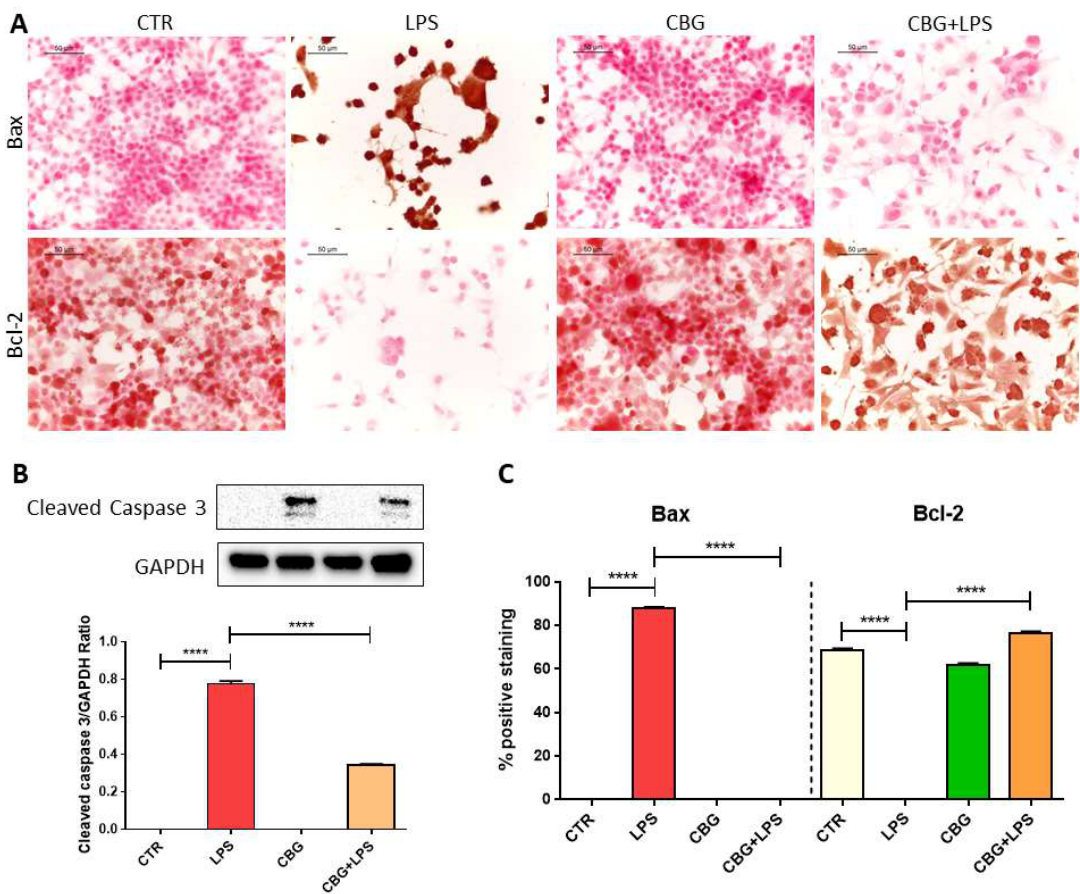
Figure 2. CBG pre-treatment was able to inhibit apoptosis induced by the medium of LPS-stimulated macrophages in NSC-34 motor neurons. ( A ) Immunocytochemistry showed that NSC-34 cells treated with the medium of LPS-stimulated macrophages expressed Bax but not Bcl-2. CBG pre-treatment abolished Bax expression and restored those of Bcl-2. ( B ) The treatment with the medium of LPS-stimulated macrophages induced caspase 3 activation in NSC-34 cells, but CBG pre-treatment reduced its expression. ( C ) Quantitative analysis of positive staining. The experiments were repeated three times. **** p < 0.0001, NSC-34 cells treated with the medium of LPS stimulated macrophages vs. NSC-34 pre-treated with CBG and then exposed to the medium of LPS stimulated macrophages, NSC-34 treated with the medium of LPS stimulated macrophages vs. control; Scale bar: 50 µm. 2.3. CBG Reduced the Expression of Pro-Inflammatory Cytokines and Proliferator-Activated Receptor γ (PPAR γ )